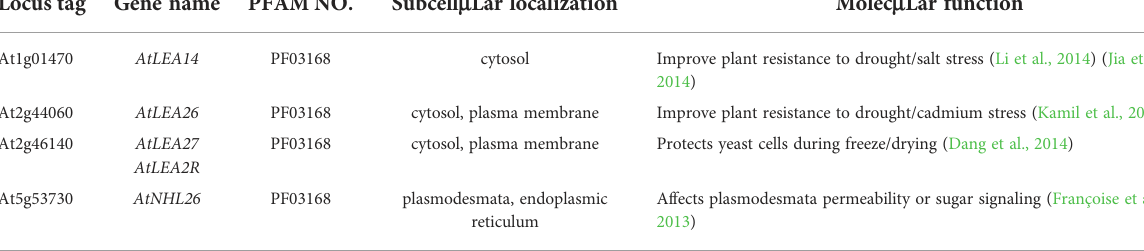
TABLE 2 Correspondence between different nomenclatures of AtlLEA_2 Gene Family. Locus